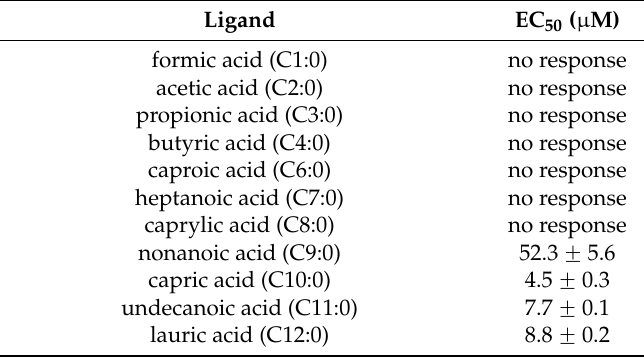
Table 3. Affinity of various fatty acids for GPR84